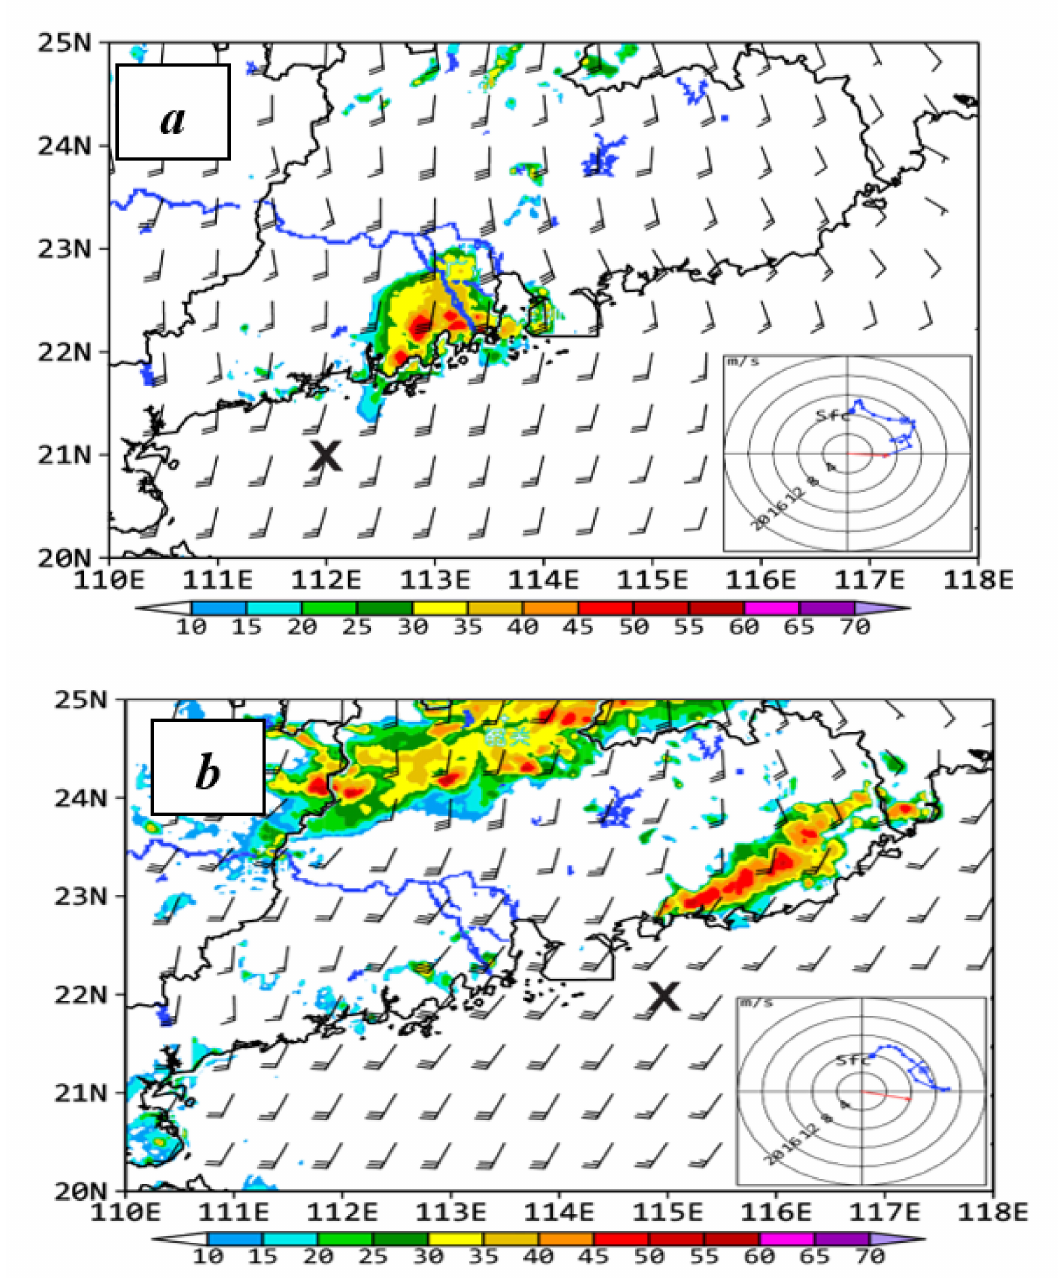
Figure 13. The NCEP GFS analysis of horizontal winds (a full barb is 4 m s − 1 ) at 925 hPa and the composite radar reflectivity (RR, shadings) mosaic at z = 1 km for the linear-shaped MCSs with hodographs taken at ‘ × ’, and a bold arrow showing the moving direction of convective cells: ( a ) horizontal winds at 0800 BST, and RR at 0600 BST 26 May 2013; ( b ) horizontal winds at 2000 BST, and RR at 2340 BST 26 May